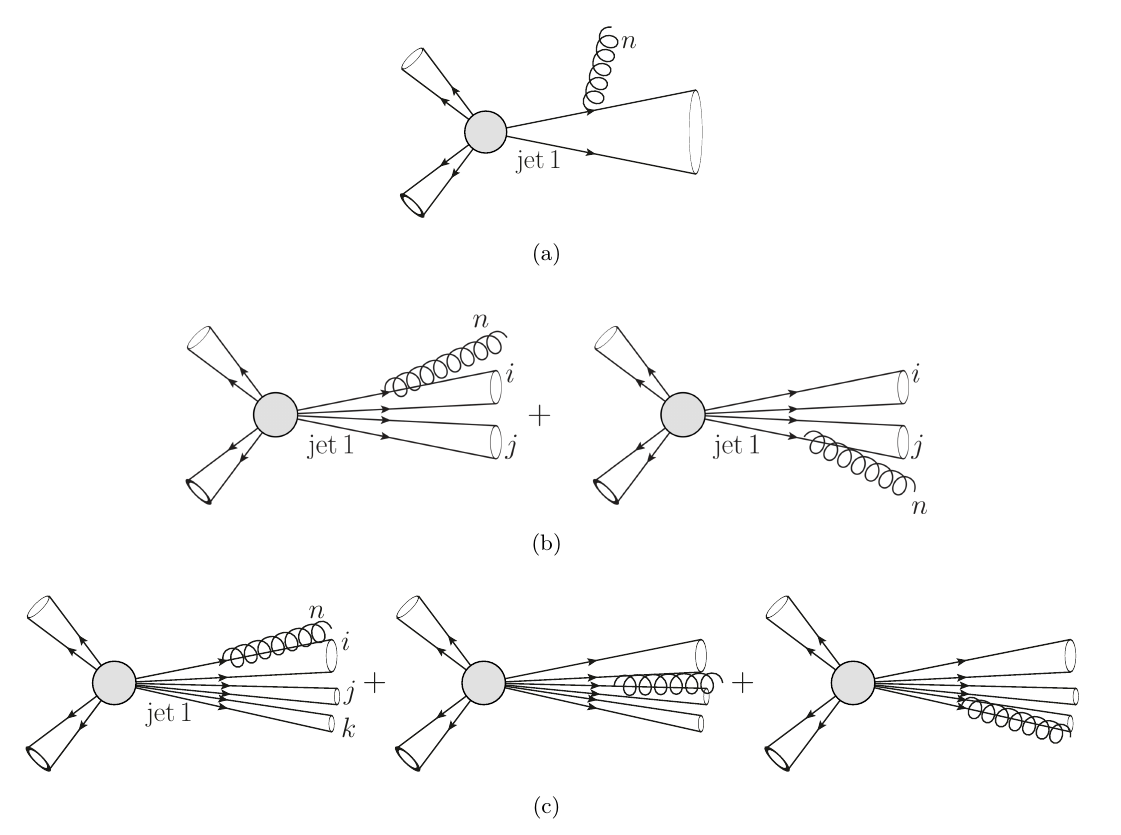
Figure 7 . Figures (a), (b) and (c) show a gluon n emitted from jet 1 (in a three-jet process) with collinear substructure at progressively finer angular scales. Cones represent jets of collinear particles and the grey circle represents the hard